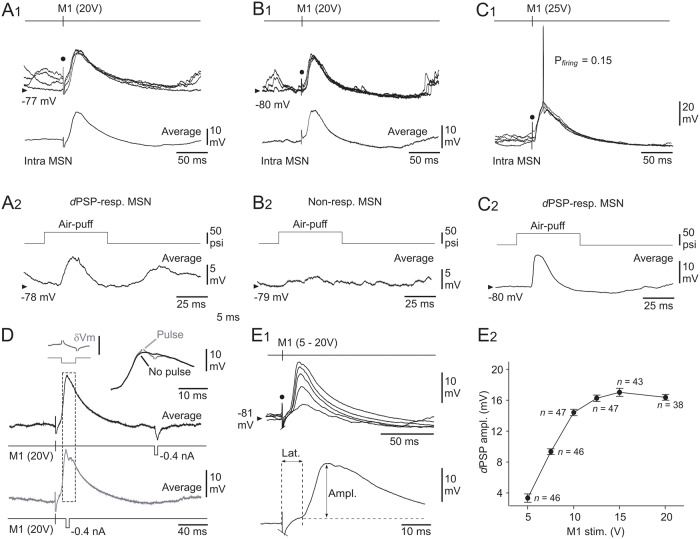
Properties of M1-induced responses in somatosensory MSNs.(A–C) Intracellular responses (four superimposed records) from three somatosensory MSNs to electrical stimulations of M1 (timing and intensity of stimuli are indicated) (A1–C1), and corresponding air-puff induced responses (averaging of 15–40 successive trials) recorded from the same cells (A2–C2). The modality of sensory responsiveness in the illustrated neurons is indicated (see text for details). The bottom traces in A1 and B1 represent the averaging of at least 20 M1-evoked intracellular potentials. (D) Conductance increase upon M1-evoked depolarizations in MSNs. M1-induced potentials (averages of 20 successive responses) in a MSN, coupled with injection of current pulses (-0.4 nA, 5 ms) applied 140 ms after M1 stimulus (black record) or at the peak of the evoked response (grey record). The traces are superimposed and expanded at right. The inset at left (δVm) shows the subtraction of both records (as delimited by the dashed box), demonstrating the collapse of current-induced voltage drop at the peak of the induced depolarization (calibration bar, 5 mV). (E) Input-output relation in the M1-somatosensory MSNs circuit. (E1) Superimposed synaptic depolarizations (averages of at least 20 responses) evoked in a MSN by M1 stimulations applied with increasing intensity (5 to 20 V). The bottom trace indicates the method used to measure the latency (Lat.) and the amplitude (Ampl.) of the M1-evoked intracellular responses. (E2) Pooled data showing the changes in dPSPs amplitude in response to M1 stimuli of increasing intensity (M1 stim.). Only MSNs tested with at least two M1 stimulus intensities were computed. Data points correspond to mean ± SEM (the corresponding number of MSNs is indicated). Note the saturation of dPSP amplitude from an intensity of 15 V. The black dots in A–C and E1 indicate the electrical stimulus artifact.